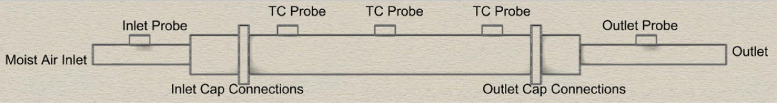
Schematic of packed bed with annotations.